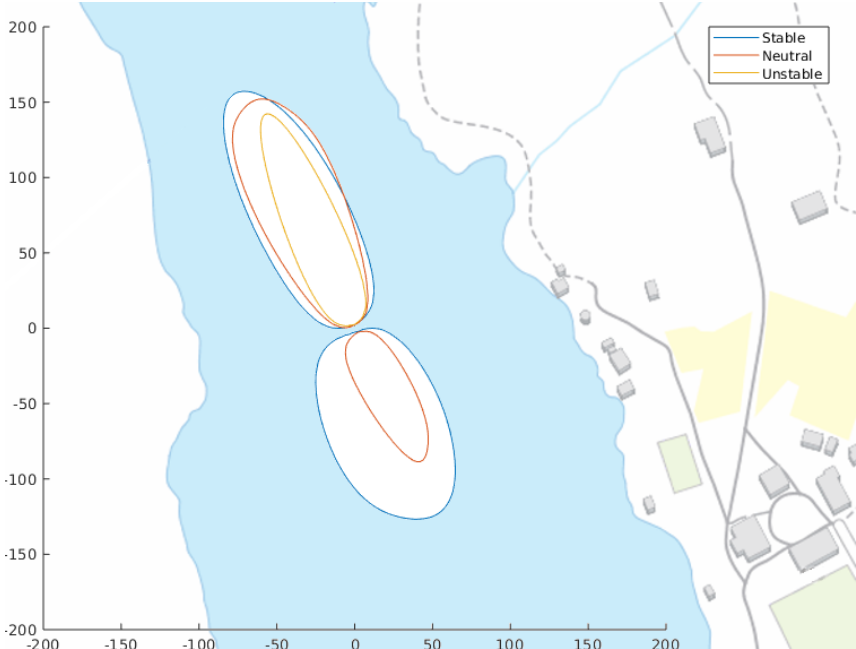
Figure 2. Footprint of EC measurements calculated from the ice-on season 2016–2017 in three stability classes: stable ( zL − 1 > 0 . 1), neutral ( − 0 . 1 ≤ zL − 1 ≤ 0 . 1) and unstable ( zL − 1 < − 0 . 1). The plotted lines represent a 80% footprint. Scale is in meters. Calculated by the footprint script described in Kljun et al. (2015). Map: National Land Survey of Finland, 1 April